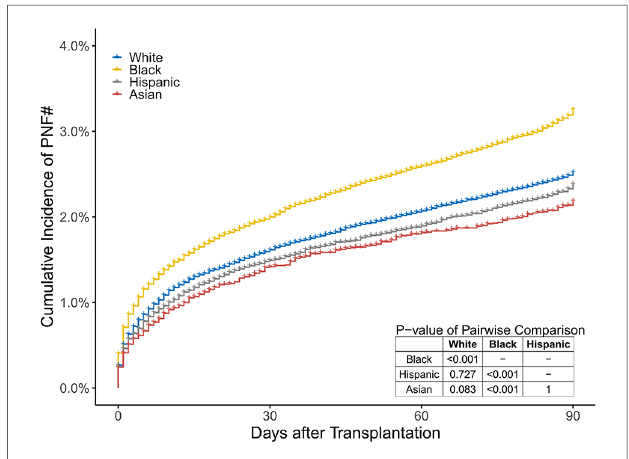
FIGURE 5 The cumulative percentage of recipients who died or suffered from PNF before discharge in the 4 groups. These two endpoints are simply referred to as PNF #